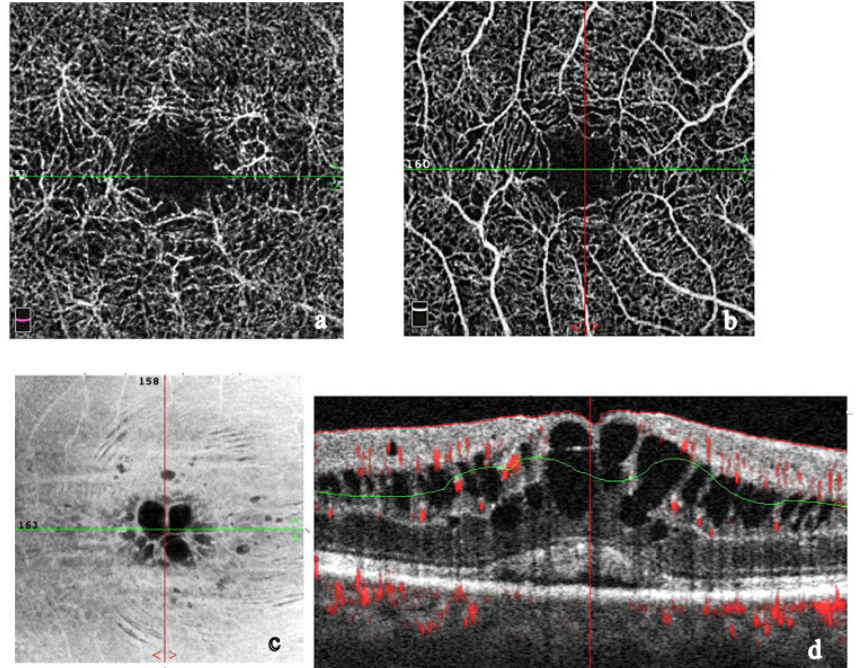
Figure 11. Angio-OCT demonstrating a disruption in the superficial capillary plexus and enlargement of the foveal avascular zone (FAZ) ( a ), with an improvement after three months of systemic therapy ( b ). Angio-OCT showing chronic inflammatory CME ( c , d ), especially at the level of the deep capillary plexus ( c ).